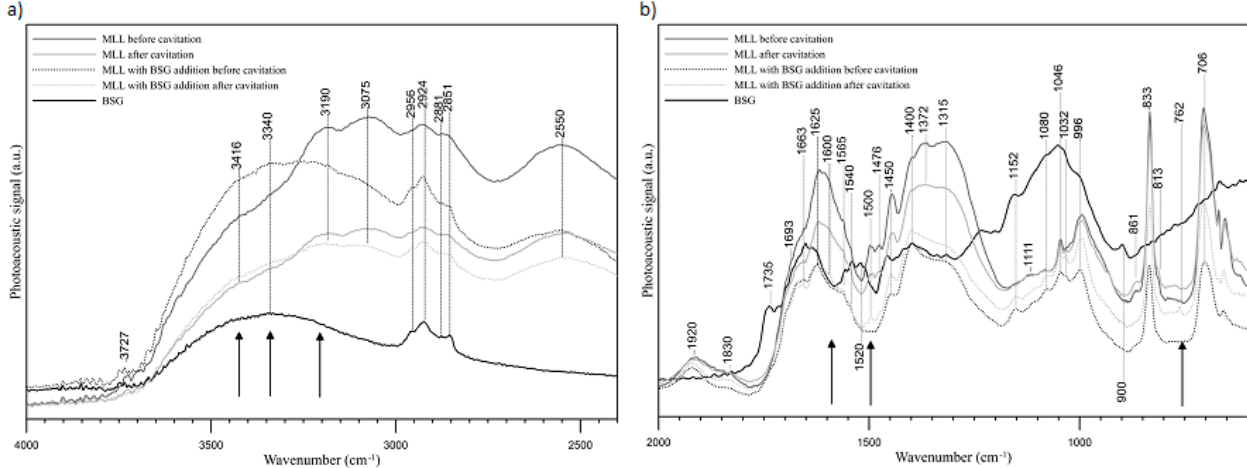
Figure 3. Fourier transform infrared photoacoustic spectroscopy (FTIR-PAS) spectra of the MLL with and without the BSG addition before and after HD in the ( a ) 4000–2400 and ( b ) 2000–600 cm − 1 range.